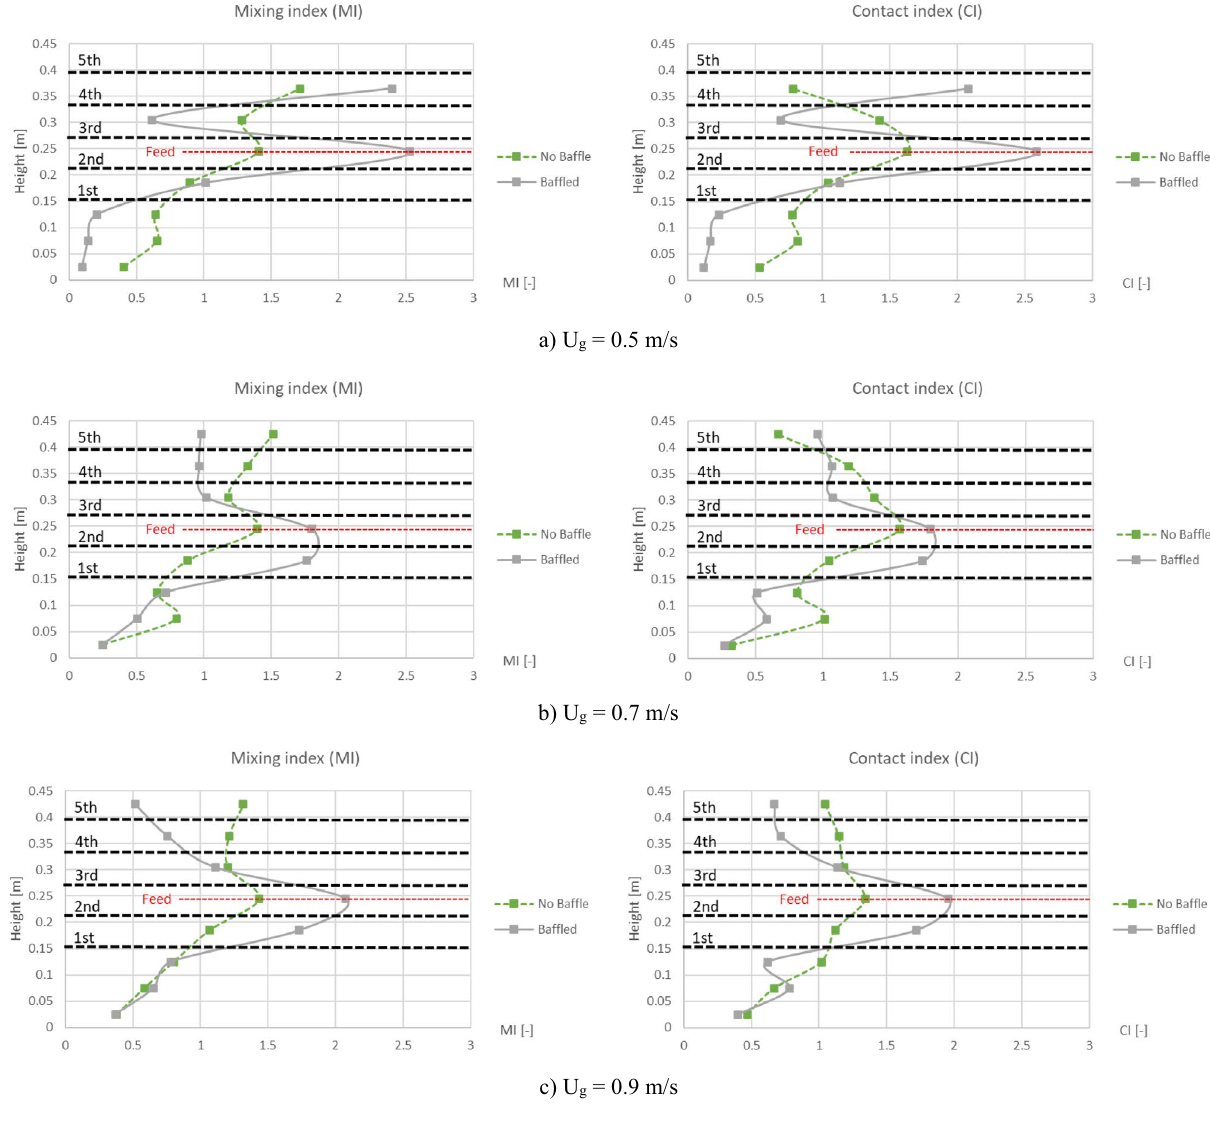
Figure 16. Time-and-area-averaged vertical mixing index (left) and contact index (right) before and after installing the baffles in case that biomass was fed at middle, when operating at various gas inlet velocities.